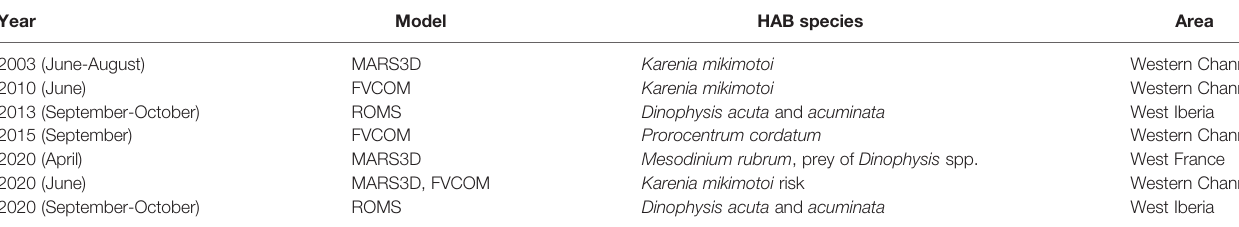
TABLE 1 | Summary of the